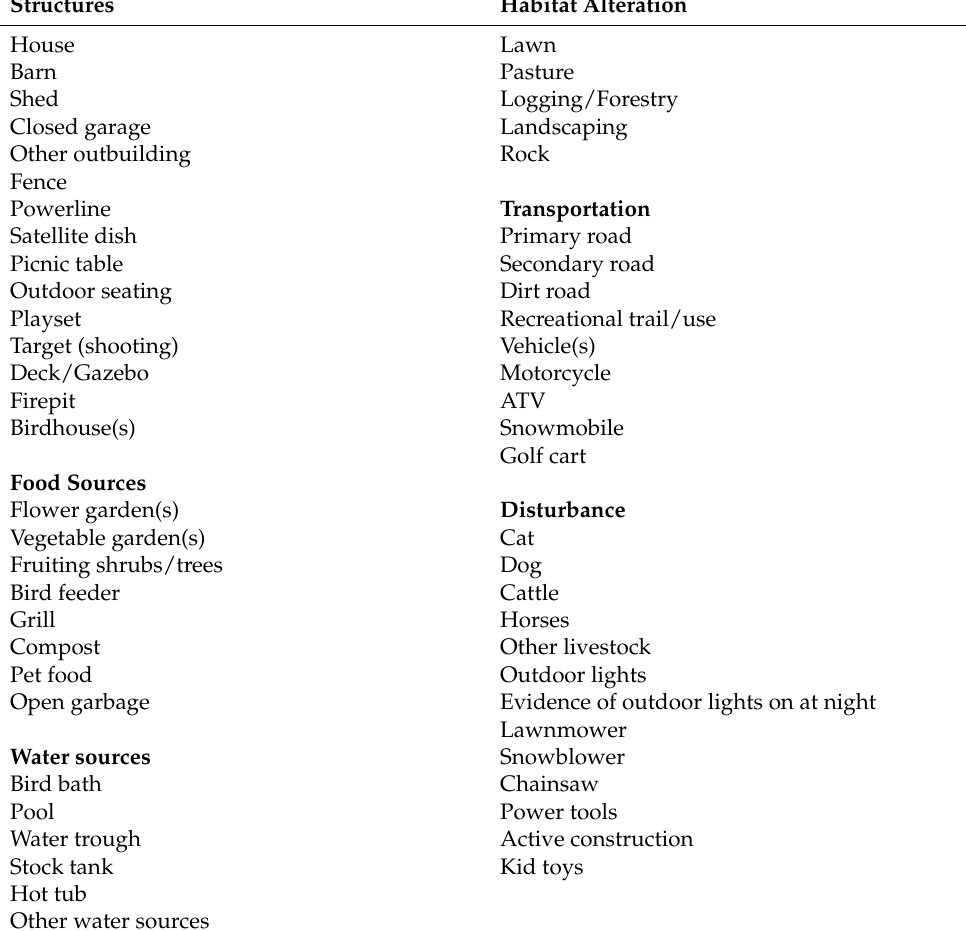
Table 1. Checklist used to record the presence of anthropogenic/land-use features observed at individual exurban parcels in Essex County, NY and Madison County, MT, USA.